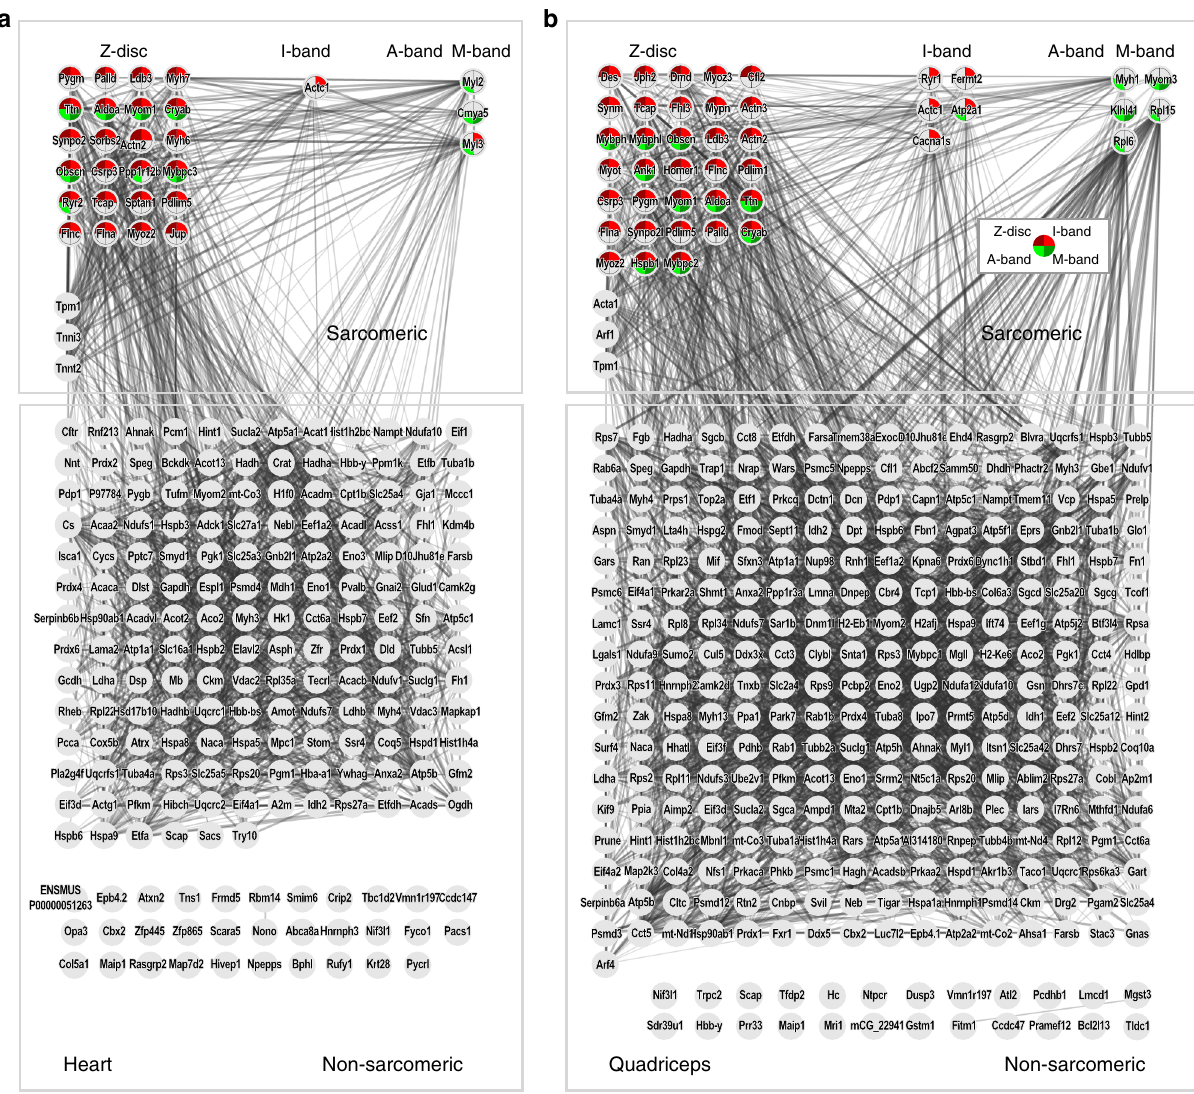
Fig. 4 Sarcomeric and non-sarcomeric proteins associate with the myo fi lament backbone. a Cardiac myo fi lament proteome with sarcomeric and non- sarcomeric proteins separated. b Quadriceps myo fi lament proteome. Gray lines represent known interactions derived from the String database, supporting the identi fi ed proteins as sarcomere associated. Colored segments represent the Gene Ontology terms Z-disc, I-band, A-band, and M-band. Proteins that do not interact are listed below the